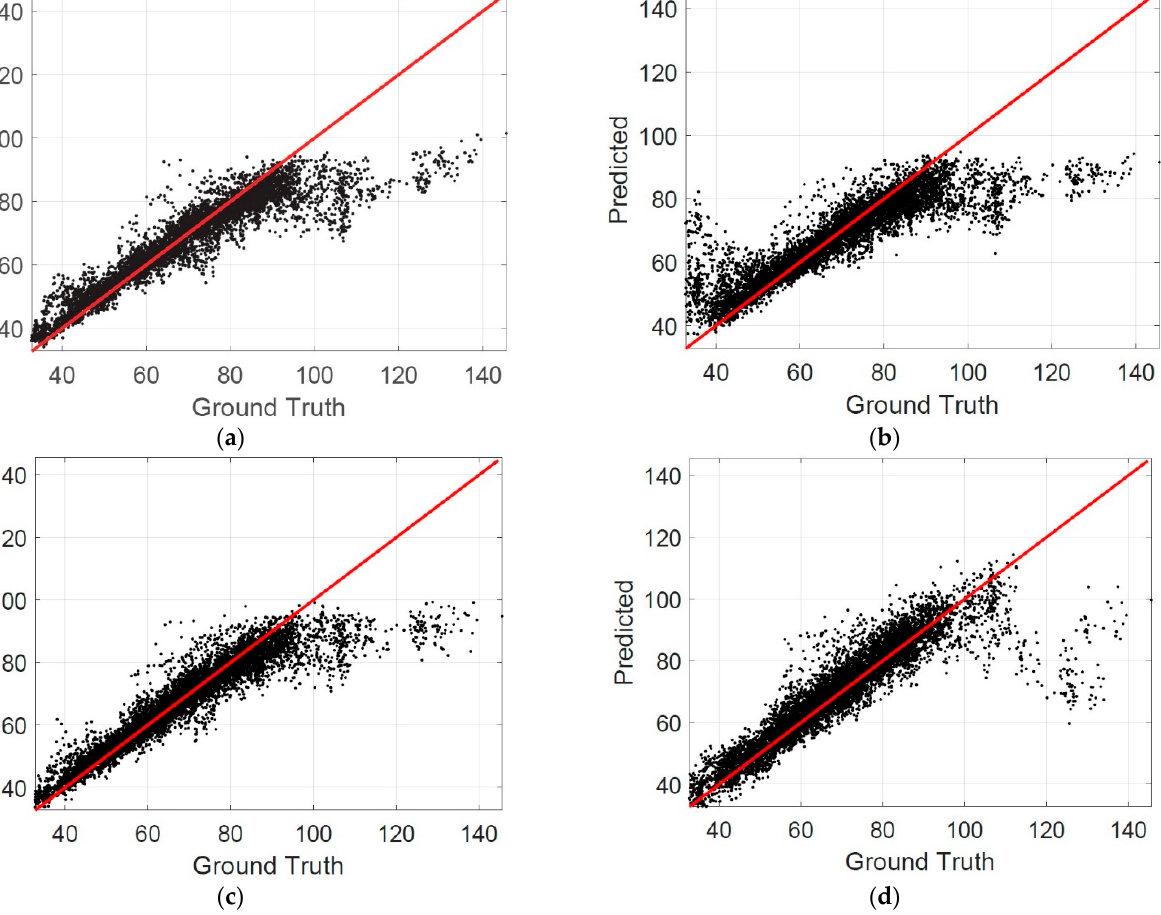
Figure 6. The scatterplots in B-scan level: ( a ) rhe patch size is 200 × 50; ( b ) 200 × 100; ( c ) 200 × 200; ( d ) 400 × 400. Table 3. The percentage of B-scans in different MAE intervals.